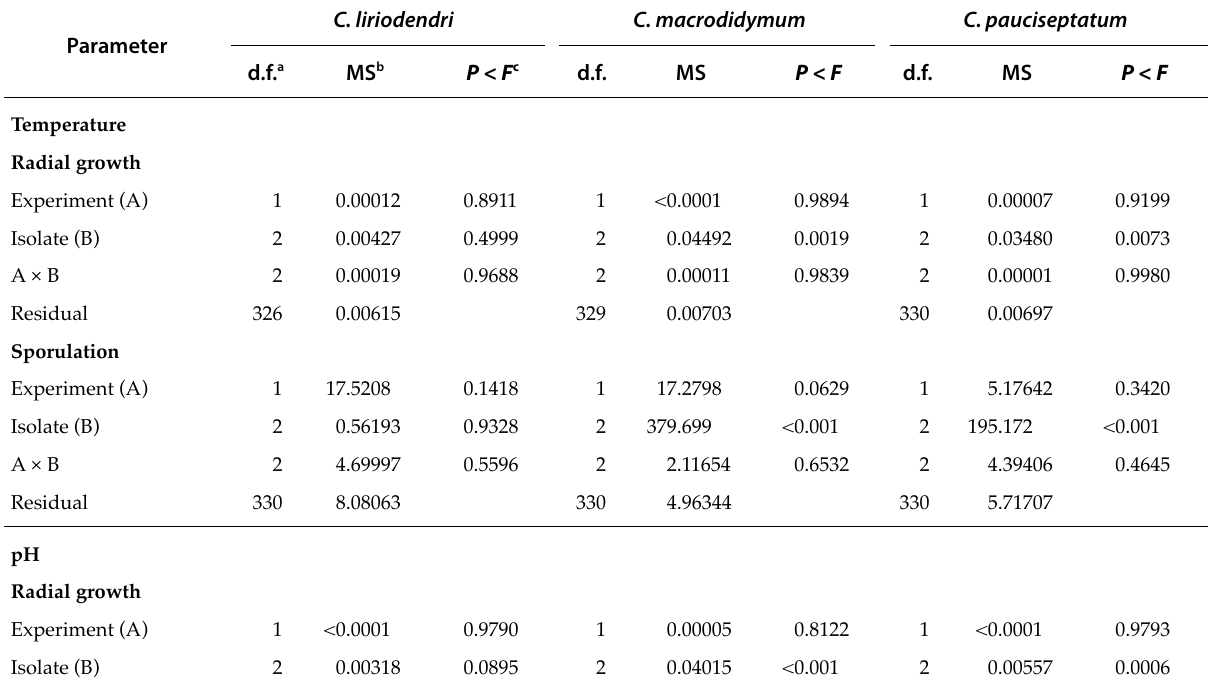
Table 2. Analysis of variance for the effects of temperature, pH and Ψ liriodendri, C. macrodidymum and C. pauciseptatum isolates.